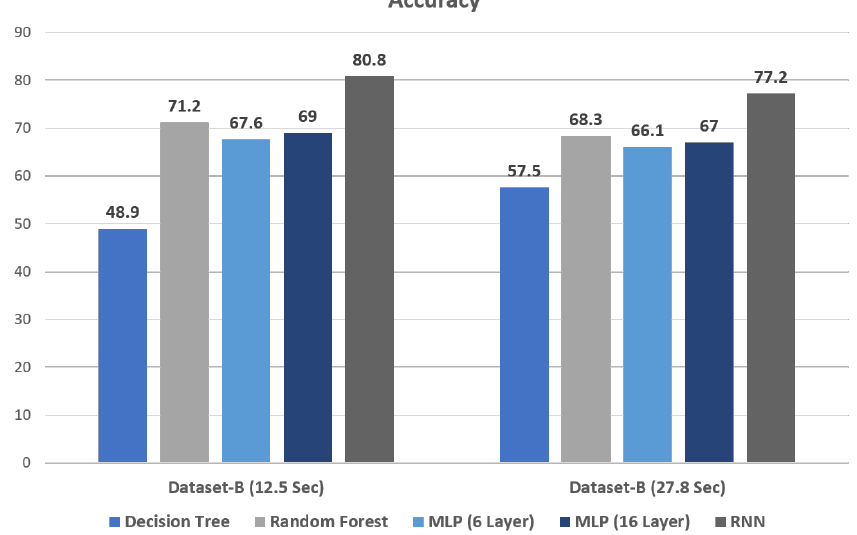
Figure 9. Accuracy Score comparison among 12.5-s and 27.8-s